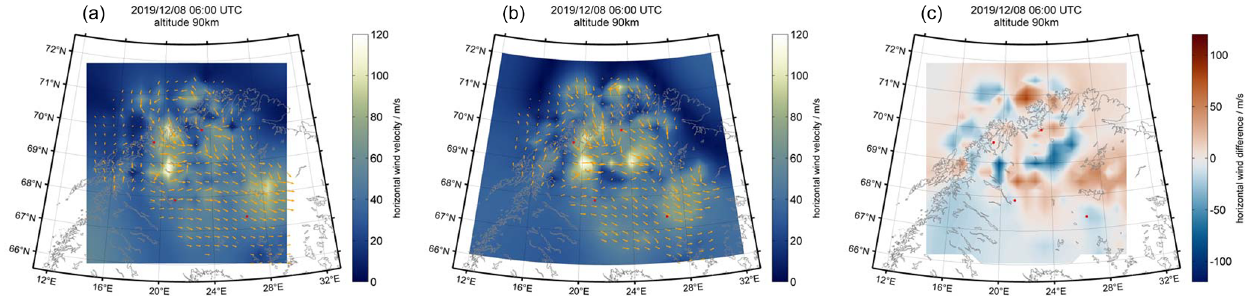
Figure 4. Image of 3D-Var retrieved wind fields obtained above the Nordic Meteor Radar Cluster using a Cartesian grid (a) and a longitude– latitude geographic grid (b) . The gray line represents the Nordic coast. The orange arrows denote wind direction and the color bar represents the wind magnitude. Panel (c) shows a difference plot between both retrievals after remapping the geographic to the Cartesian grid using cubic